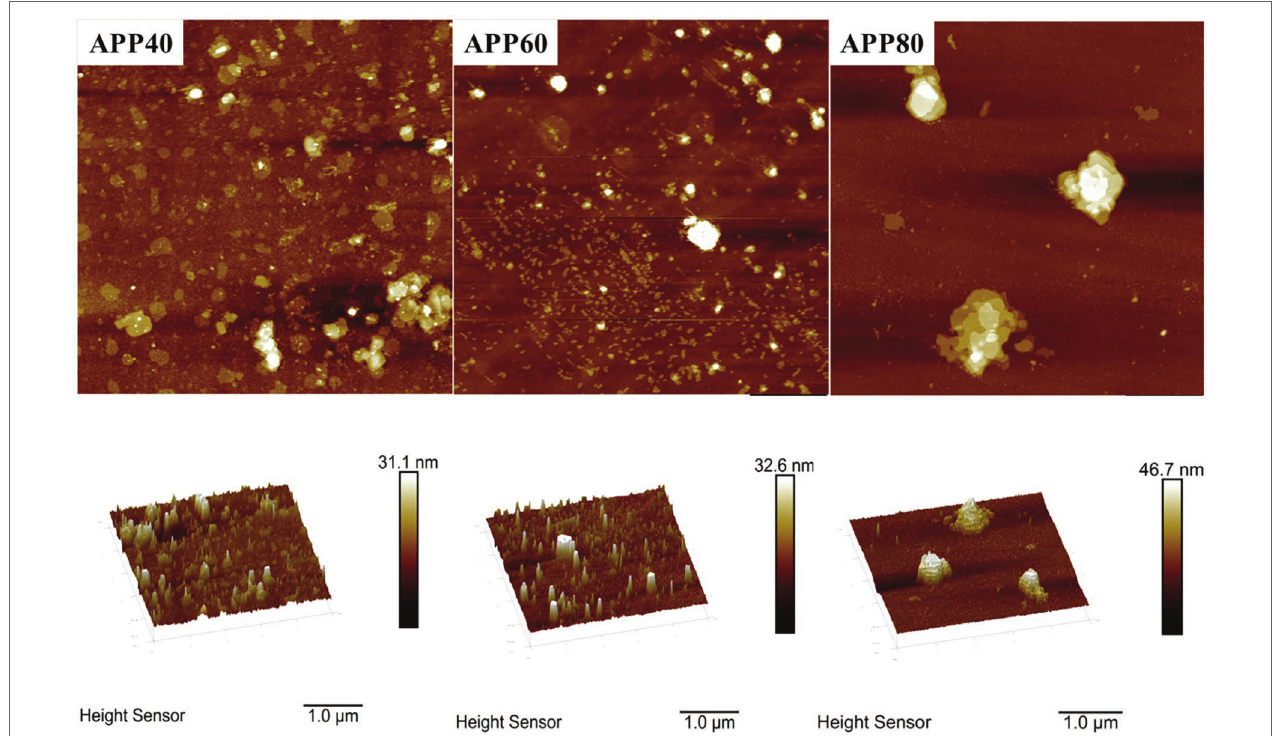
FIGURE 8 | Atomic force micrograph of precipitated at the ethanol concentration of 40% (APP40), precipitated at the ethanol concentration of 60% (APP60), and precipitated at the ethanol concentration of 80%